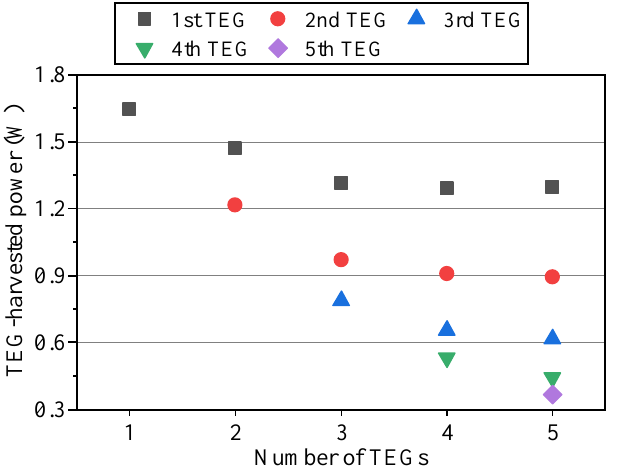
Figure 14. TEG-harvested power consisted of the system net power and the total fan power in all the systems at their system net power.